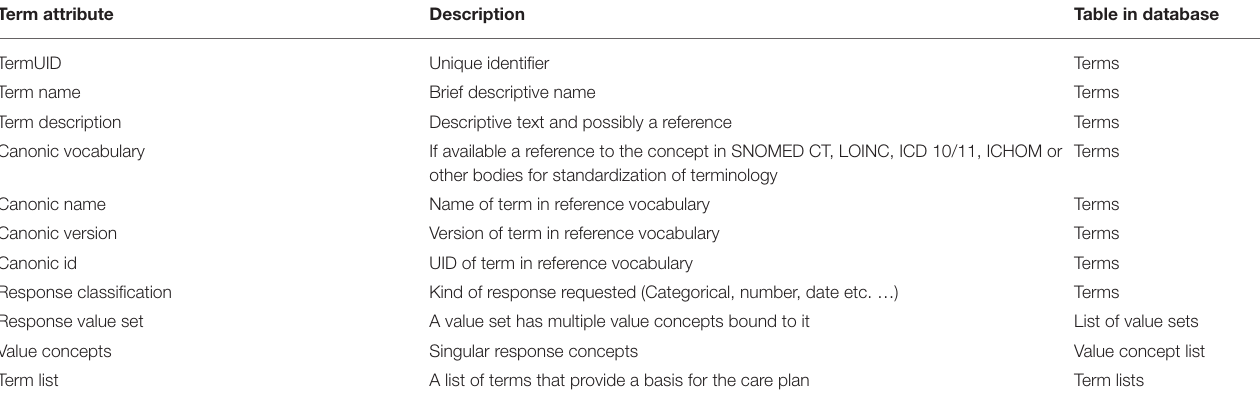
TABLE 4 | The term construct that was developed. The term annotation was common for all three steps (planning, capture and analysis) and thereby any measurement or observation can be traced back to its